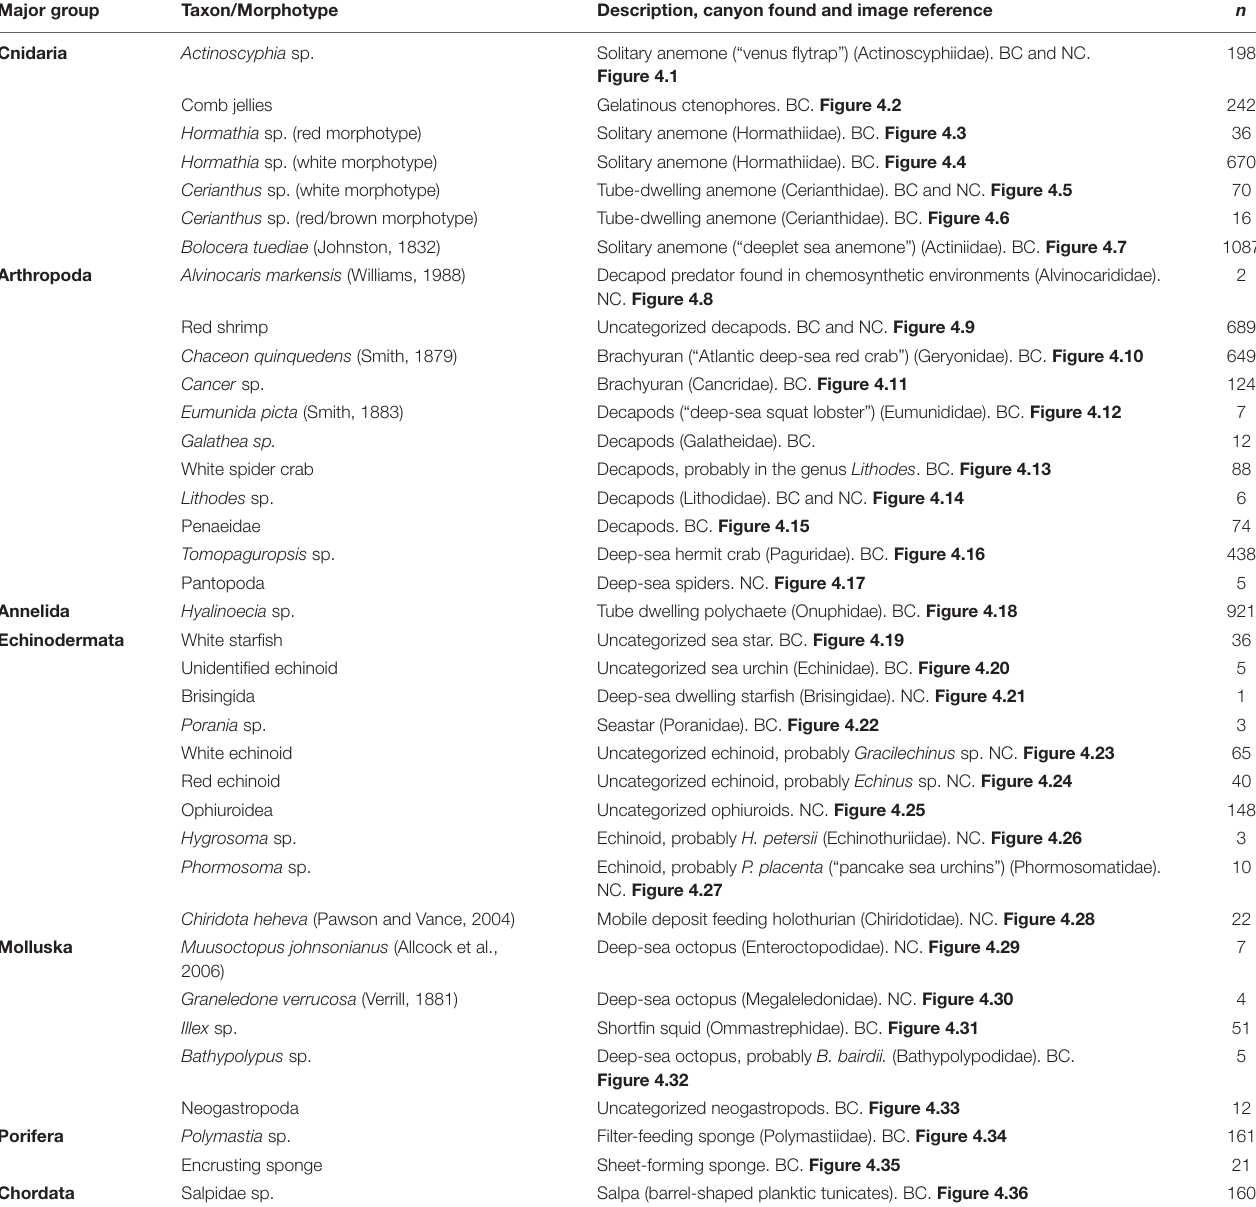
Sheet-forming sponge. BC. Figure 4.35